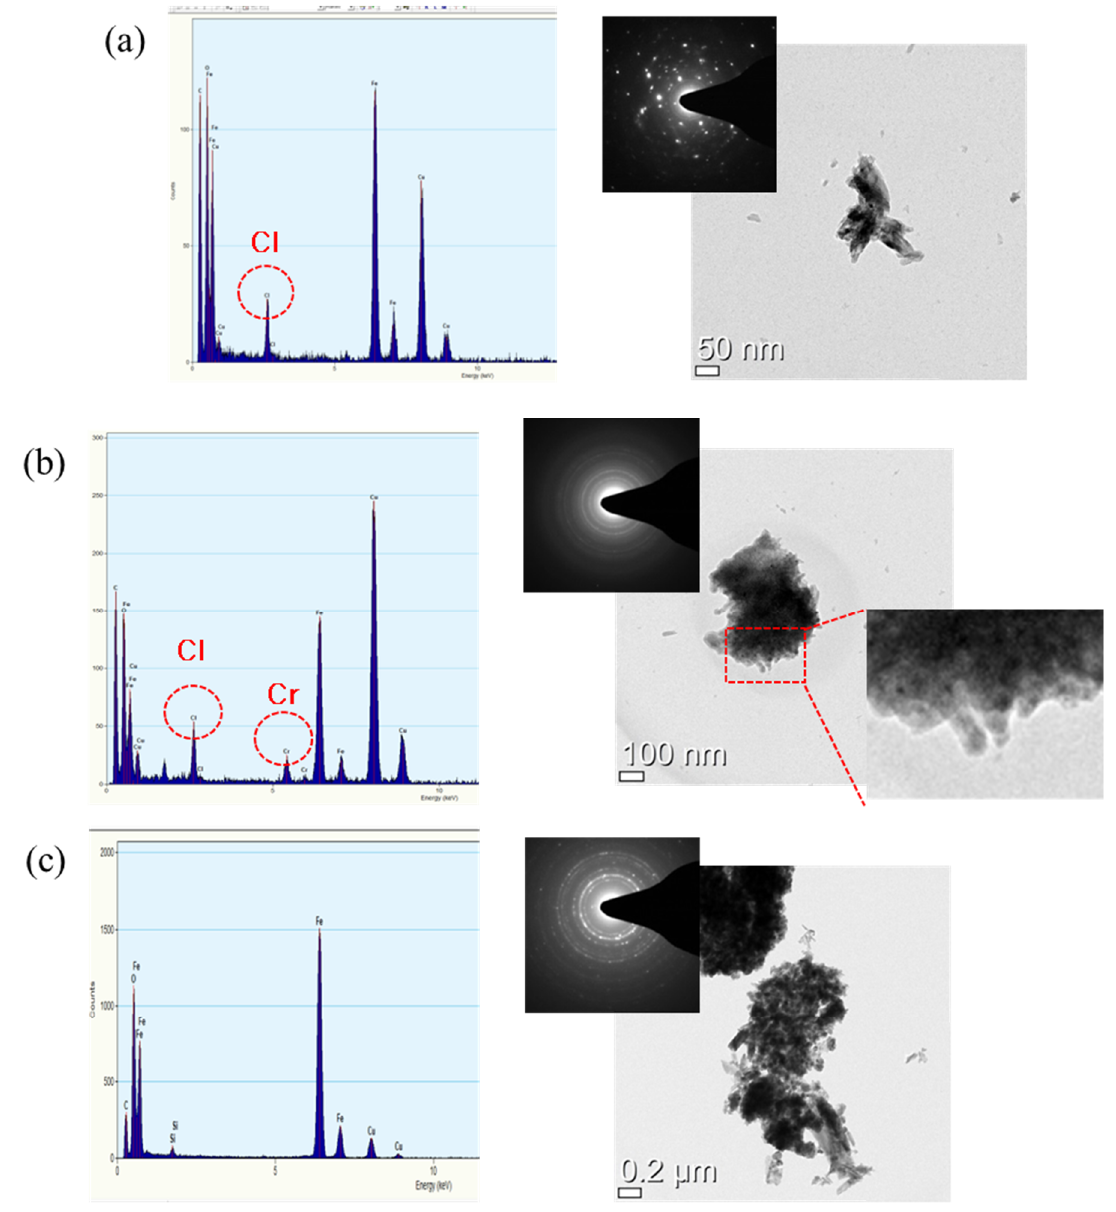
Figure 10. TEM images and the diffraction patterns of ( a , b ) inner rust and ( c ) outer rust formed on the 0.5 Cr steel.